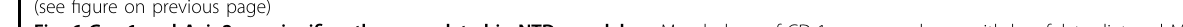
Fig. 6 Gcm1 and Axin2 are signi fi cantly upregulated in NTDs models. a Morphology of CD-1 mouse embryos with low-folate diet and MTX induced from E9.5, left panel is control mouse fetus, right panels are NTDs mouse fetuses. The arrowhead is where the NTDs located; the left panel of NTDs embryos is schizencephaly. Scale bars, 100 μ m. b The mRNA expression of Gcm1 in the brains and spines of NTD model mice. * P = 0.0003 (brains) and * P = 0.01 (spines). c The mRNA expression of Axin2 in the brains and spines of NTD model mice. * P = 0.002(brains) and ** P = 0.02 (spines). d Increased expression of Gcm1 and Axin2 in NTD mouse brains. Left panel: western blots of Gcm1 in normal and NTD brains; right panel: bar graph showing the quanti fi cation of the western blot signal intensities. e Increased expression of Gcm1 and Axin2 in NTD mouse spines. Left panel: western blots of Gcm1, Axin2 in normal and NTD brains; right panel: bar graph showing the quanti fi cation of the western blot signal intensities. f A Co-IP assay was used to identify the interaction between Gcm1 and TCF4, β -catenin in control and NTDs mouse brains. An anti-Gcm1 antibody was used for IP, and an anti-TCF4 antibody and anti- β -catenin was used for IB, Con was for Control. g A Co-IP assay was used to identify the interaction between Gcm1 and TCF4, β -catenin in control and NTDs mouse spines. An anti-Gcm1 antibody was used for IP, and an anti-TCF4 antibody and anti- β -catenin was used for IB, Con was for Control. h Folate concentrations in control human fetal brain tissue and spina bi fi da human fetal brain tissue. The data were obtained from 40 human fetus brains. i Increased expression of Gcm1, Axin2, and Atoh1 in human NTD brain samples. Left panel: western blots of Gcm1 in brains of normal humans ( n = 20) and human NTD ( n = 20) samples; right panel: bar graph showing the quanti fi cation of the western blot signal intensities. j The mRNA expression of Gcm1 , Axin2 , and Atoh1 in the NTDs fetuses, determined by Nanostring ( n = 12). k Correlation analysis of folate concentration and Gcm1 mRNA expression (left panel); Gcm1 mRNA expression and Axin2 mRNA expression , Atoh1 mRNA expression (right panel) n = 12. l A Co-IP assay identi fi ed an interaction between Gcm1 and β -catenin in randomly selected low-folate fetal brains. Data a – h , l represent the mean ± SEM ( n = 3). Data i represent the mean ± SEM ( n = 20), Data j, k represent the mean ± SEM ( n = 12), The p value was calculated by Student ’ s t -test, ns was for no signi fi cance, * P < 0.05, ** P < 0.01, *** P <